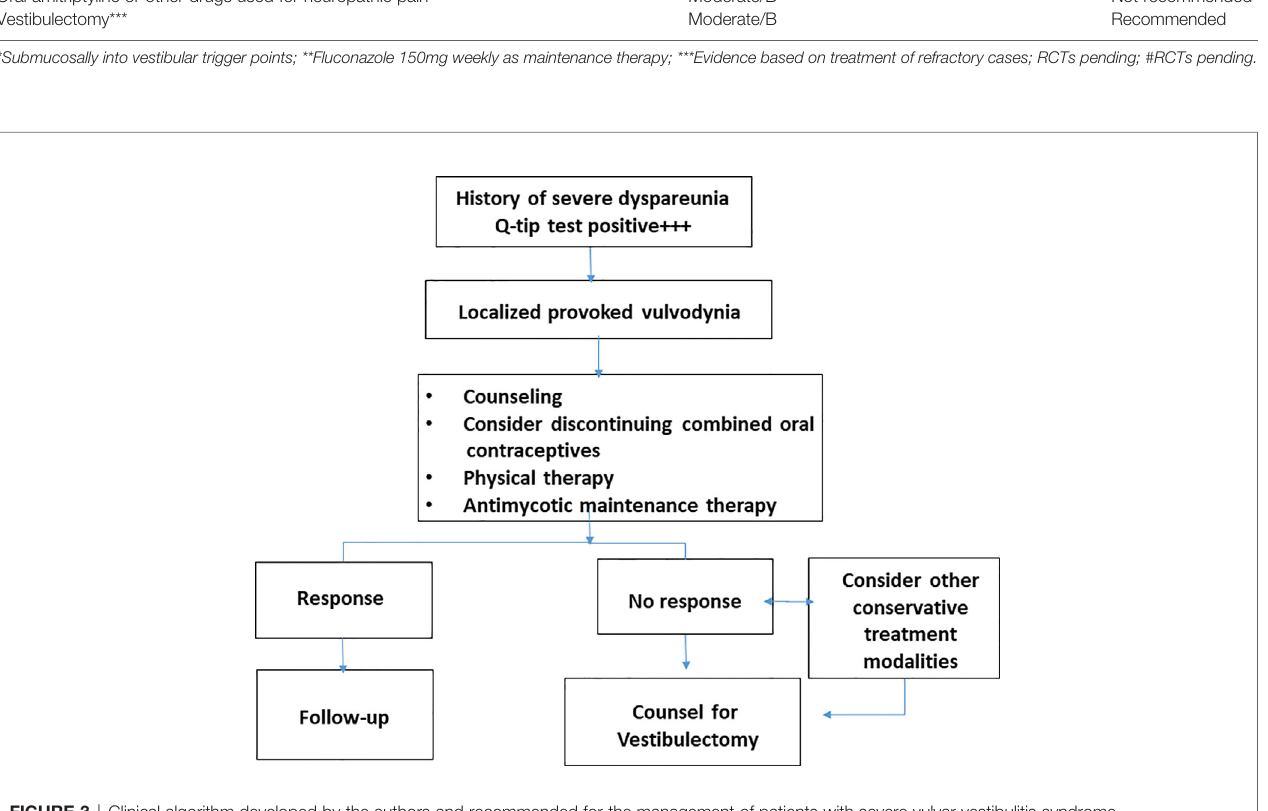
Frontiers in Cellular and Infection Microbiology |